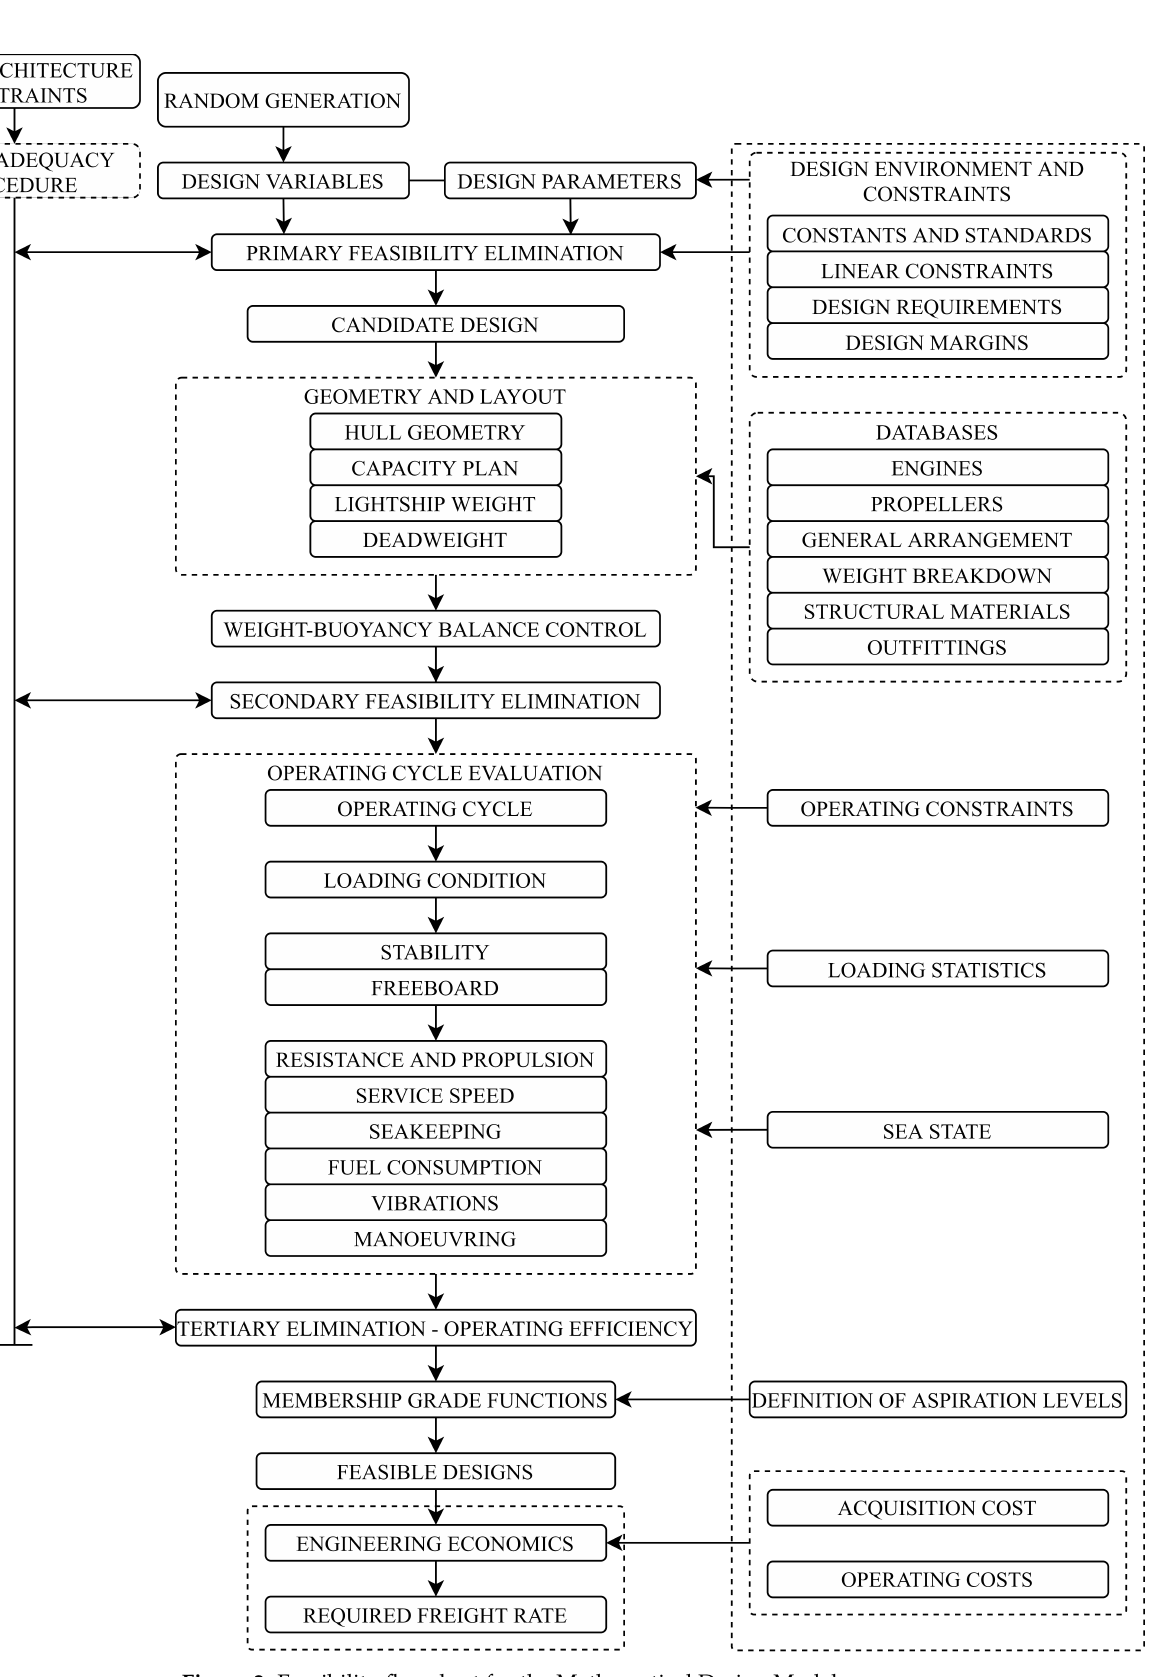
Figure 2. Feasibility flowchart for the Mathematical Design